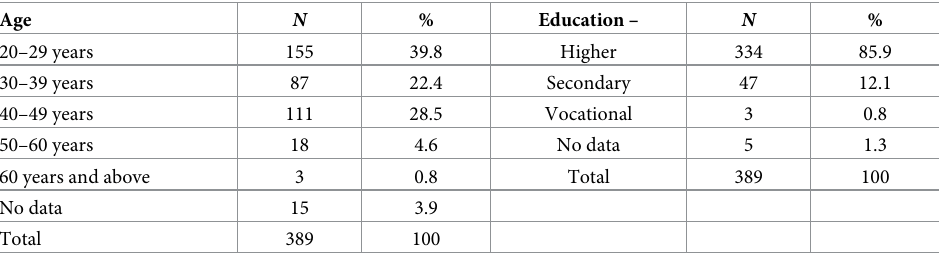
Table 1. Age and education of the